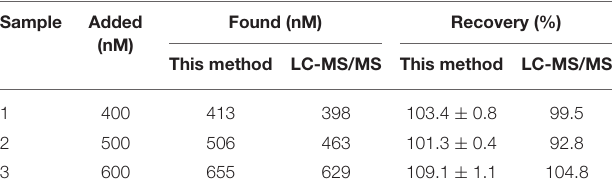
TABLE 3 | Results for the detection of different amounts of kanamycin spiked in milk by this established method and LC-MS/MS ( n = 3).